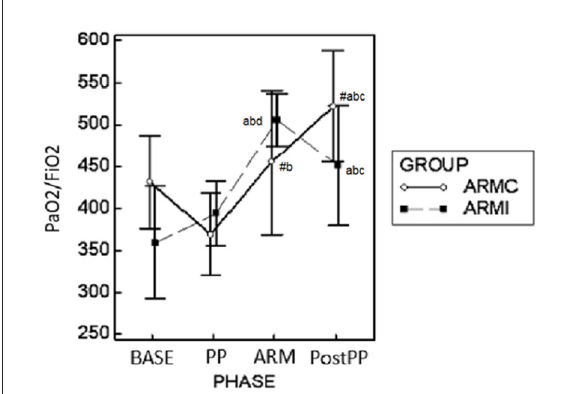
FIGURE2 Graphical representation of the mean ± standard deviation values of PaO 2 /FiO 2 in 20 dogs mechanically ventilated, undergoing laparoscopic surgery. Ten dogs (ARMc) received a “stepwise” ARM, and the other (ARMi) received a “sustained inflation” ARM followed by 5 cmH 2 O of PEEP. The parameters were evaluated 10min before (BASE) and after (PP) the induction of PP, 10min after the maneuvers (ARM), and 10min after the discontinuation of PP (Post-PP). # p < 0.05 between the two groups at the same study time. a p < 0.05 in the same group compared with BASE; b p < 0.05 compared with PP; c p < 0.05 compared with ARM; d p < 0.05 compared with